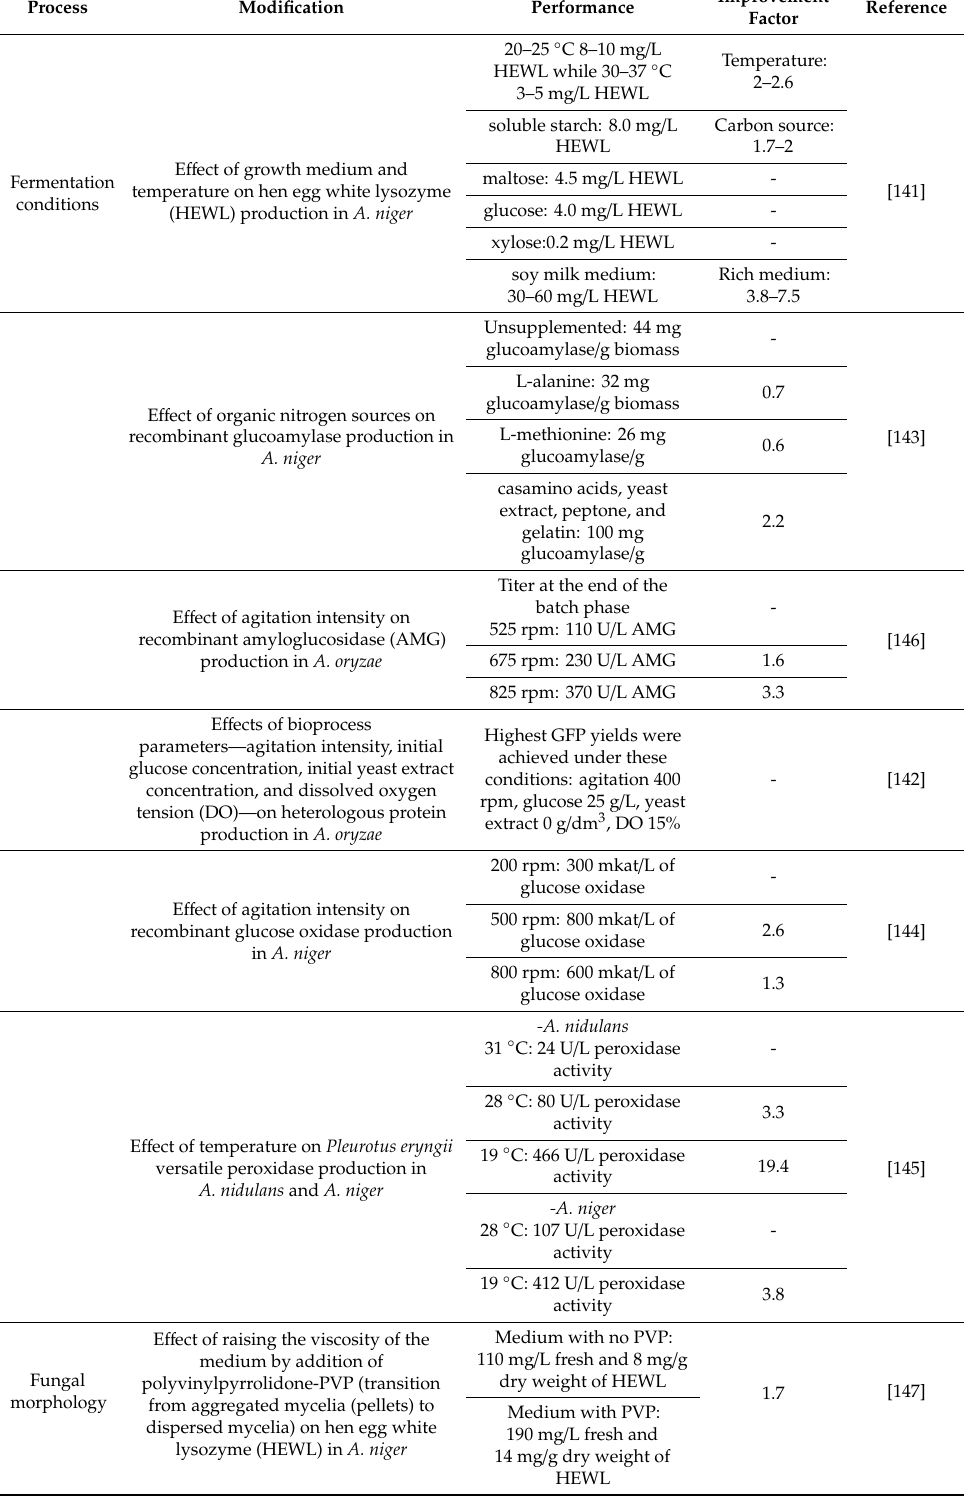
Table 12. Approaches for improving recombinant protein production through bioprocessing